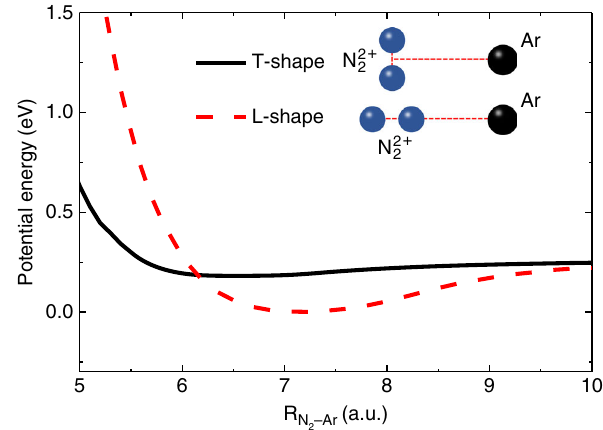
Fig. 2 Measured KER distributions of N + ion transfer channel. The blue solid circles are experimental results. The error bars are standard statistical uncertainties. The red curve is a fi t to the experimental data, and its peak locates at 4.9 eV. Source data are provided as a Source Data fi le.